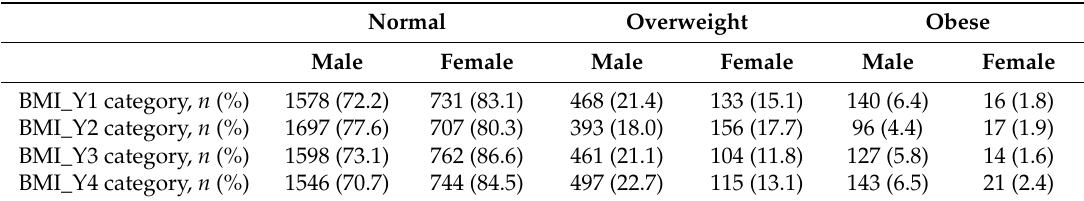
Table 1. BMI distribution according to sex over four